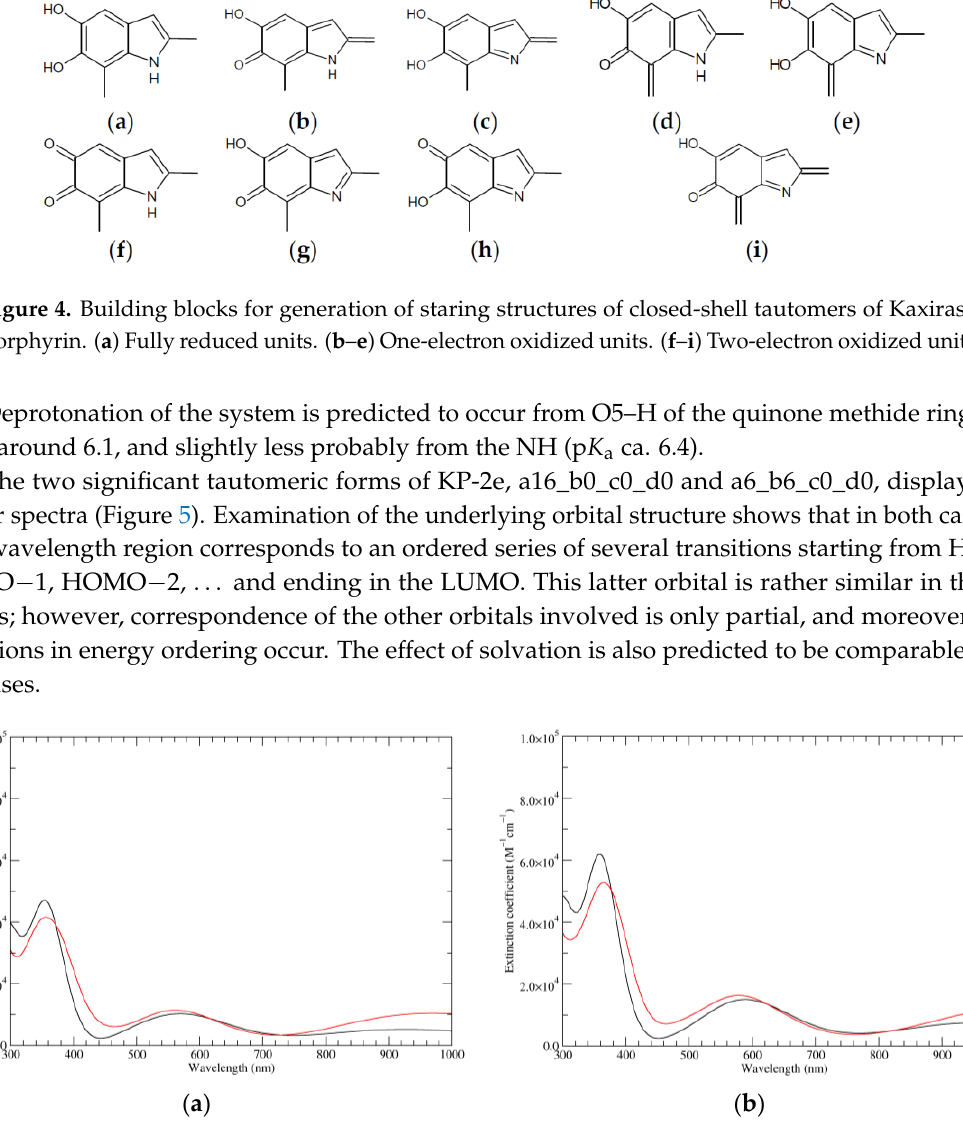
Figure 5. Computed UV–Vis spectra of the most significant tautomers/conformers in the two-electrons oxidation state. ( a ) Neutral form in vacuo: black line, a16_b0_c0_d0, C 1 , conf1; red line, a6_b6_c0_d0, C 1 , conf1. ( b ) Neutral form in water: black line, a16_b0_c0_d0, C 1 , conf1; red line, a6_b6_c0_d0, C 1 , conf1.